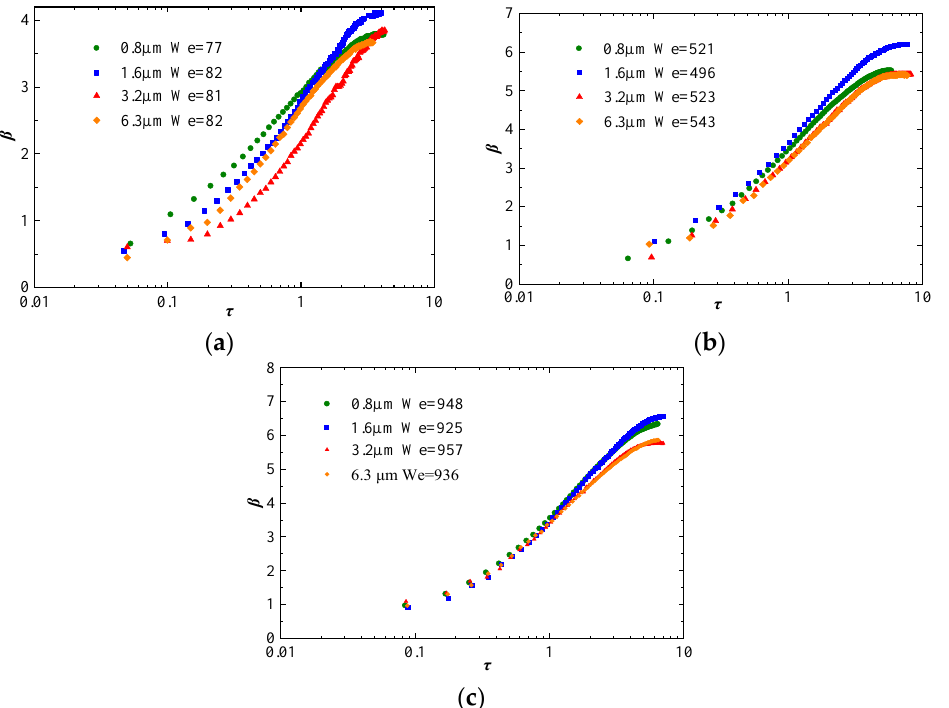
Figure 7. Influence of surface roughness on β - τ curve at three different We . ( a ) Low We. ( b ) Medium We. ( c ) High We